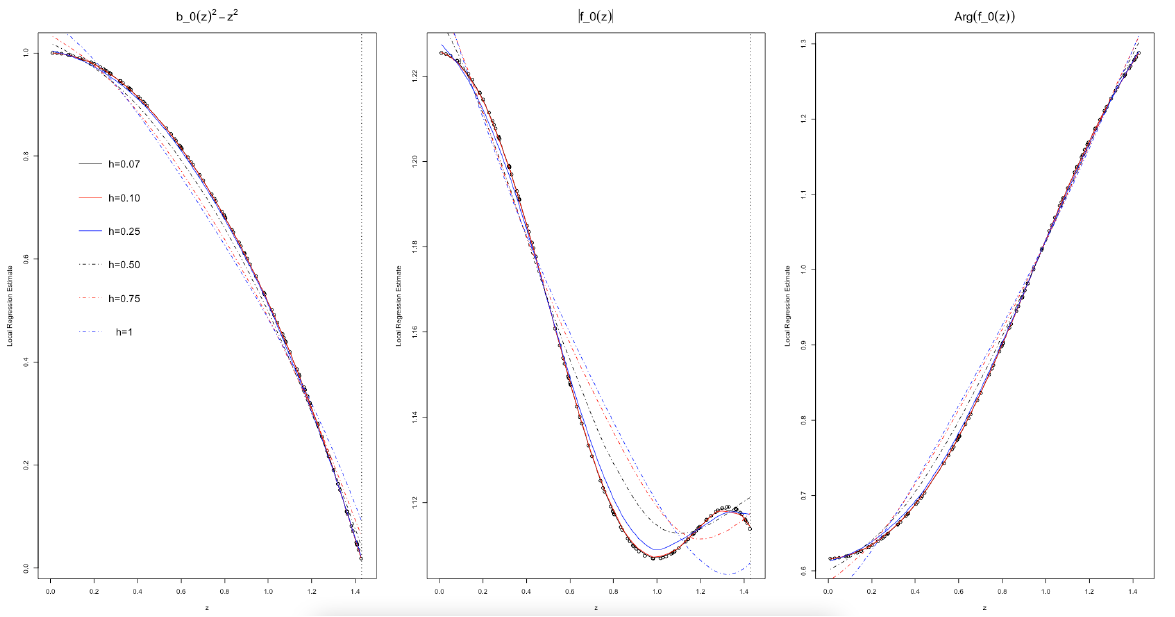
Figure 1. The estimates of critical collapse functions corresponding to α solution of hyper- bolic case based on a local regression method of order l = 1 with bandwidth parameters h =